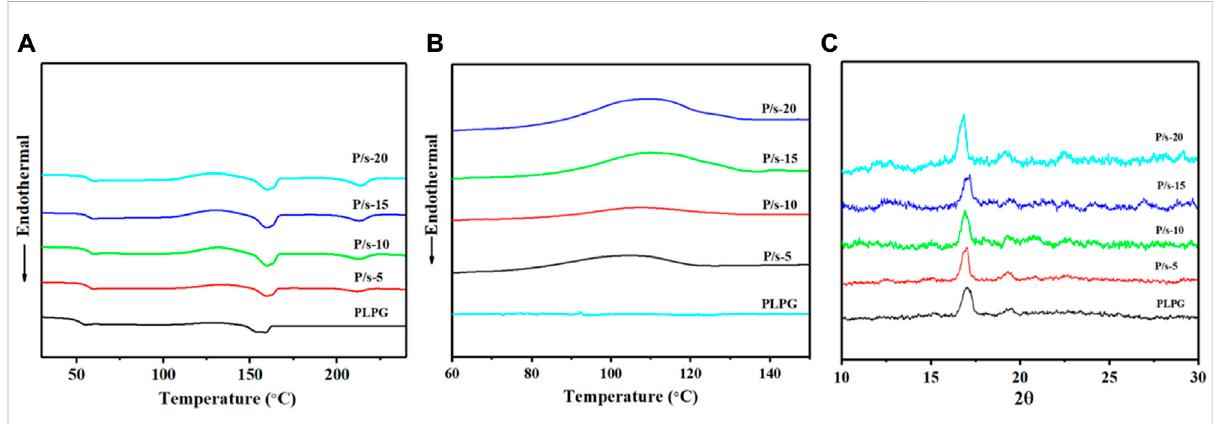
FIGURE 1 (A) Melting curves from 25 ° C to 230 ° C at 10 ° C/min. (B) Non-isothermal crystallization curves. (C) WAXD pro fi le of the membrane at 3 ° C/min.